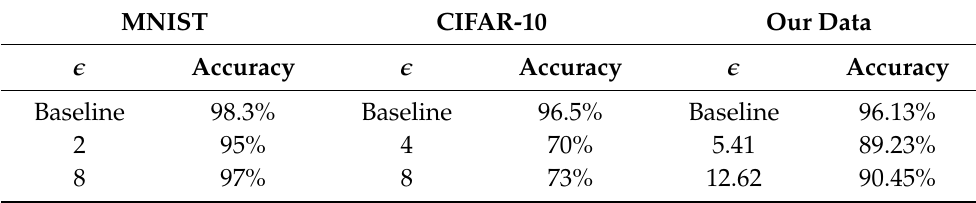
Table 3. The accuracy between different